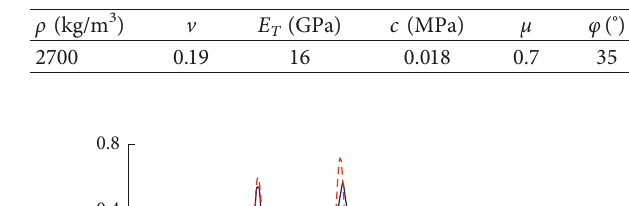
Table 1: Parameters of stemming.